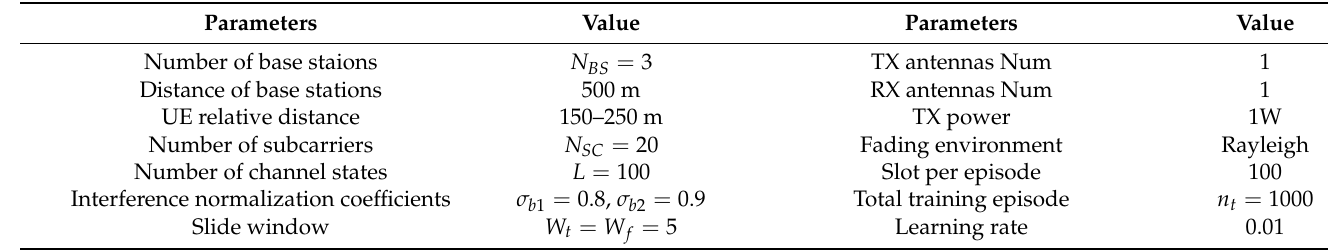
Table 1. The parameters of the simulation